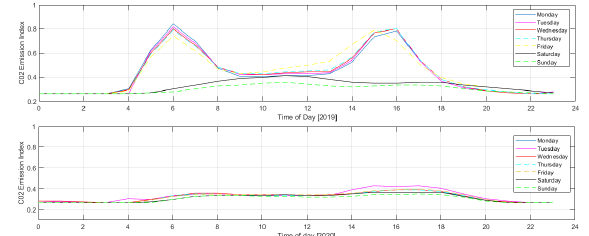
Figure 5: CO 2 emission index: 2019 Average trends (top) vs lock-down (bottom)